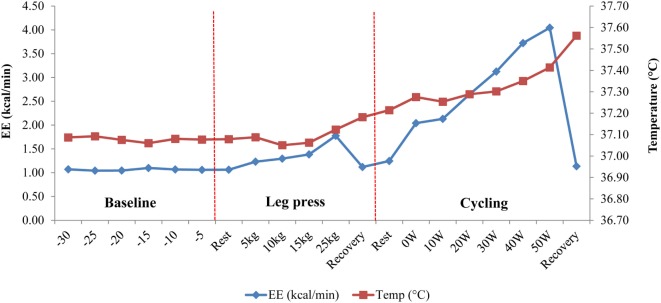
Temperature change in response to dynamic (cycling) and isometric (leg press) exercises in one subject. Following a 30-min baseline measurement period, energy expenditure (EE) and core body temperature (Tc) were measured simultaneously during an isometric leg press exercise (5–25 kg) followed by low power cycling (0–50 W) on an ergometer bicycle. Note the sudden drop in EE during “Recovery” periods, which contrasts with the continuous increase in Tc, probably due to thermal lag time between total heat production and total heat loss (3).